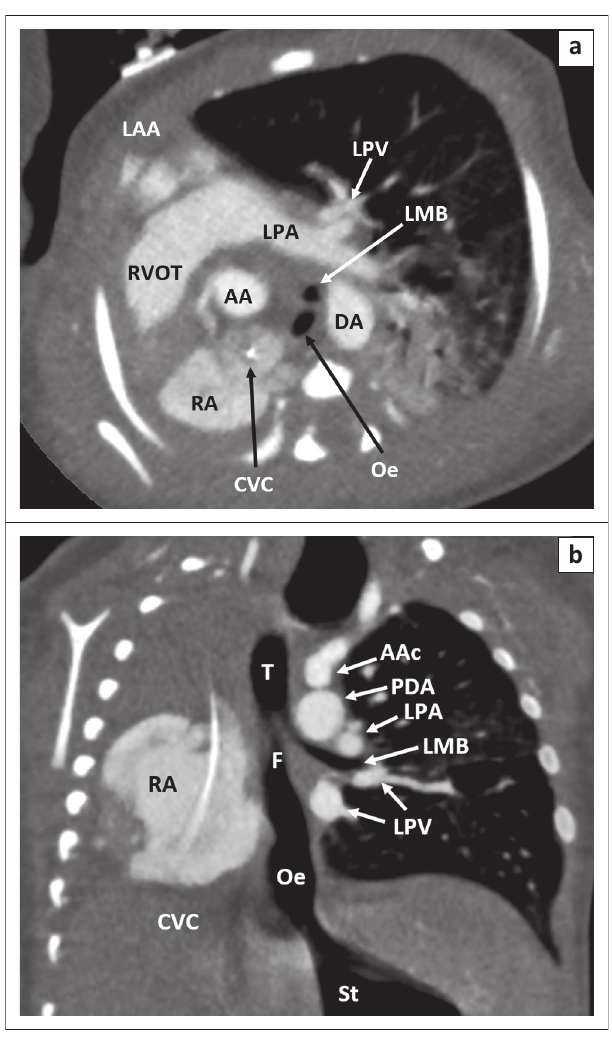
FIGURE 3 : Computed tomography angiography thorax in the axial (A) and oblique coronal (B) planes reveals absence of the right lung, bronchus and pulmonary vessels with ipsilateral mediastinal shift. The left pulmonary artery (LPA) and veins (LPV) are present with a hyperinflated left lung. The trachea (T) divides into the left main bronchus (LMB) and communicates with the lower oesophagus (Oe) via a fistula (F) consistent with a tracheo-oesophageal fistula. The patent ductus arteriosus (PDA) is large. The tip of the central venous catheter (CVC) is in the right atrium